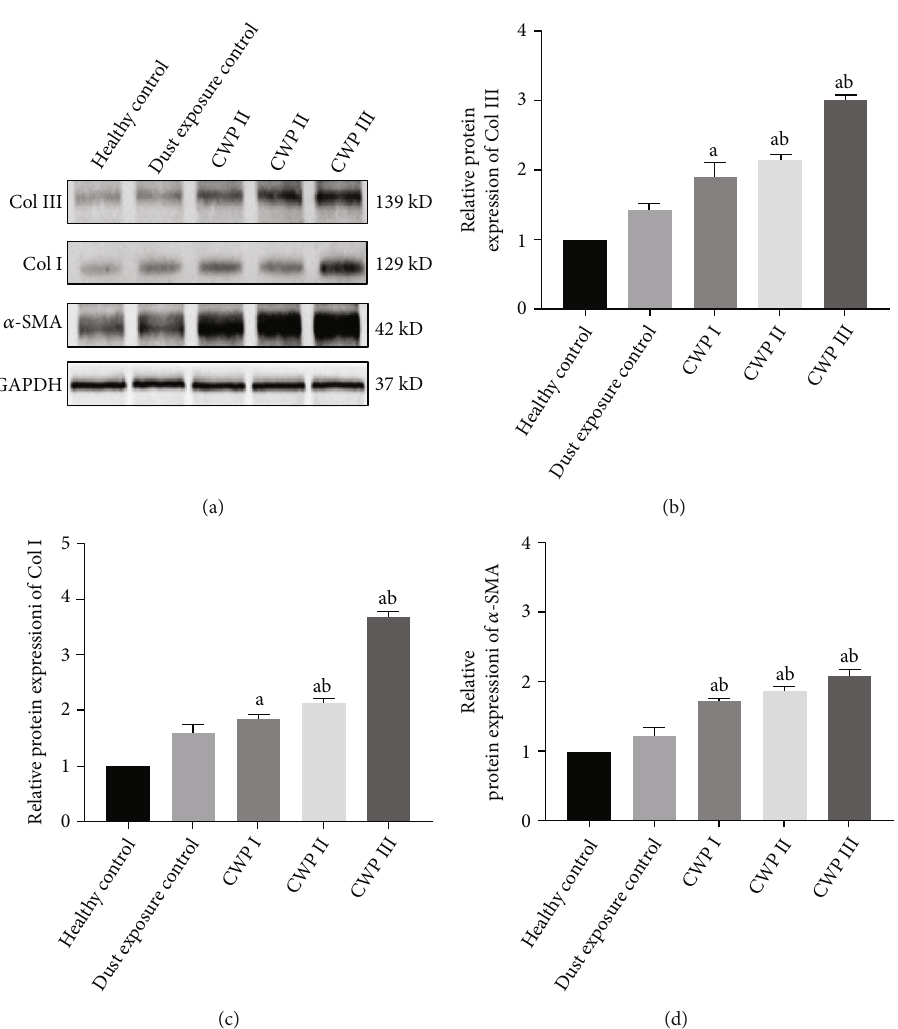
Figure 2: Relative expression level of fi brosis-related proteins by western blot analysis. (a) Expression of fi brosis-related proteins in serum by western blot analysis. (b) The relative protein expression level of Col III. (c) The relative protein expression levels of Col I. (d) The relative protein expression level of α -SMA. a P < 0 : 05 , compared with the healthy control group. b P < 0 : 05 , compared with the dust exposure control